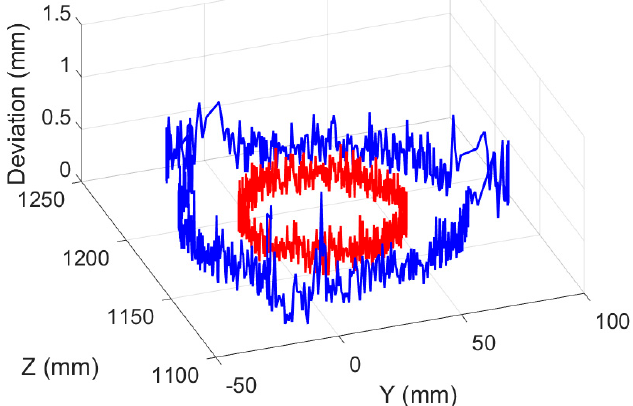
Figure 32. Deviation results of target planning path and actual tool path of experimental deburring for top facet. Appl. Sci. 2019 , 9 , x FOR PEER REVIEW 23 of 28